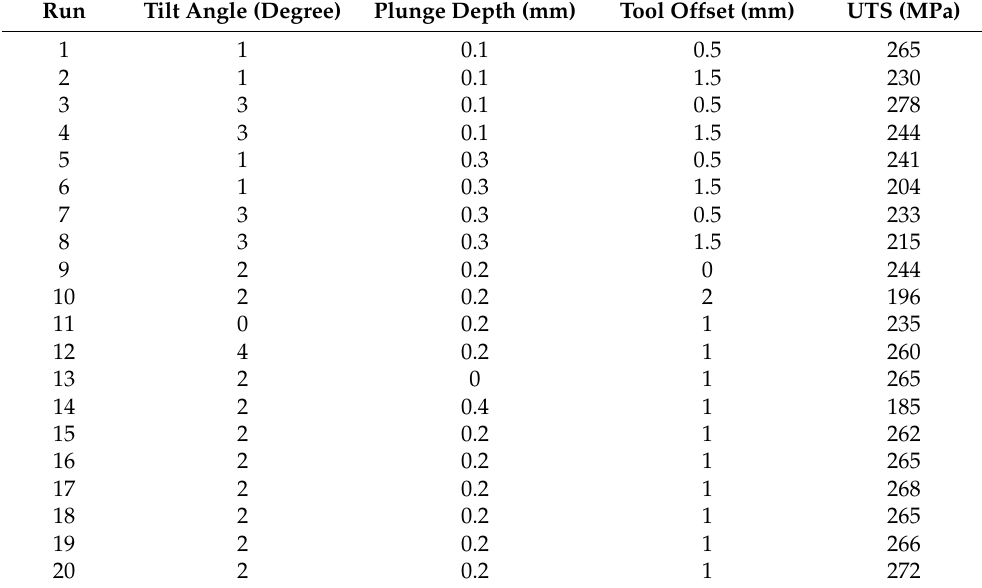
Table 5. Design matrix and UTS values.